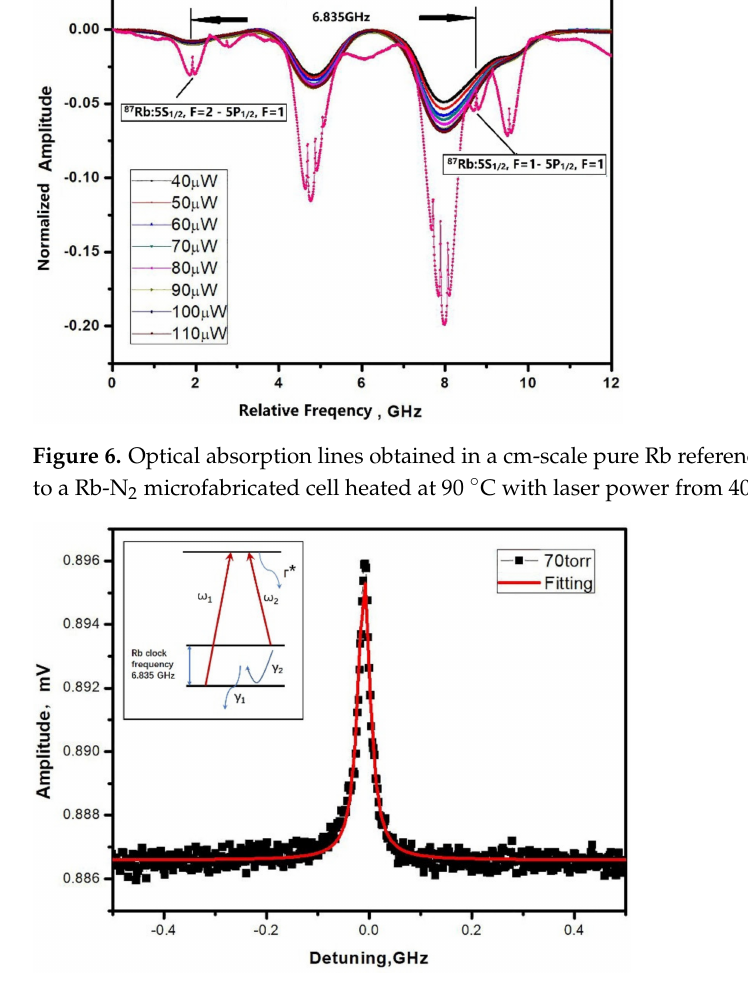
Figure 7. Typical CPT resonance obtained in a Rb-N 2 cell (inset: simplified schematic of three-level system involved in Rb cells CPT resonances, Γ * : linewidth of the optical resonance). The red line is a Lorentzian fit to the experimental data (black